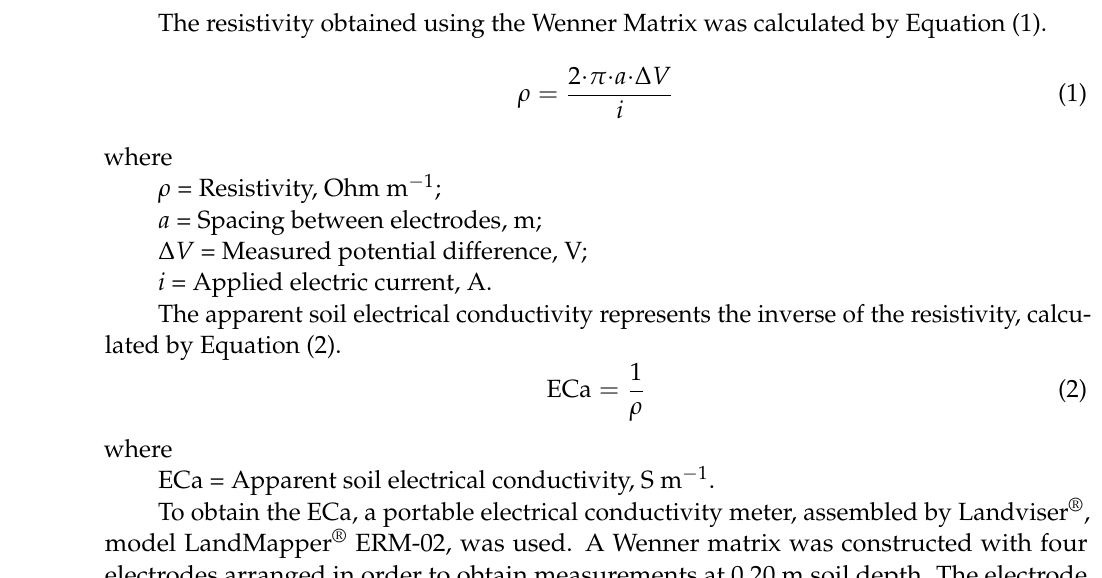
Figure 1. Soil sampling grid used to evaluate apparent soil electrical conductivity (ECa) in field A under rainfeed, of 26.7 hectares ( a ), and in field B under center-pivot irrigation, of 24.1 hectares ( b ). Cachoeira do Sul, RS.